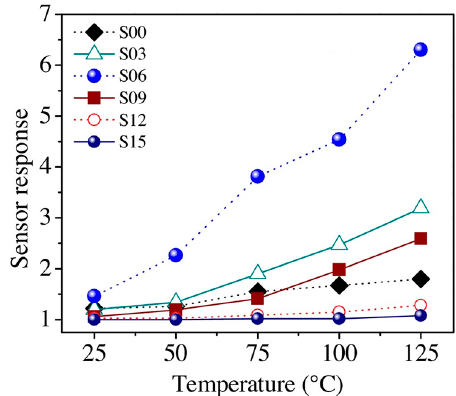
Figure 62. 1000 ppm ethanol sensing response of pure ZnO (S00) and ZnO decorated with Au NPs of different amount (S03–S15) under UV illumination intensity of 4.1 mW/cm 2 . Reproduced with permission from [88].